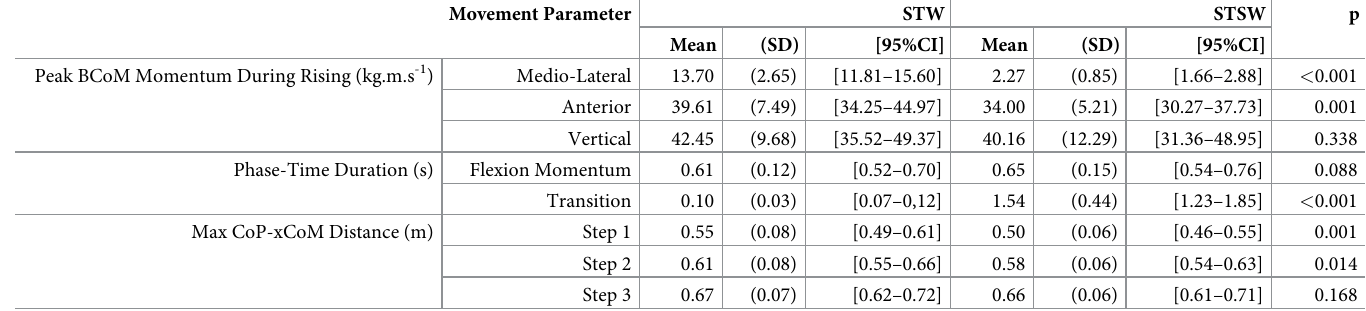
Table 6. Mean (SD) [95%CI] comparison for peak BCoM momentum, phase-time durations, and maximum CoP-xCoM distance during steps 1–3 between STW and STSW. Movement Parameter Peak BCoM Momentum During Rising (kg.m.s -1